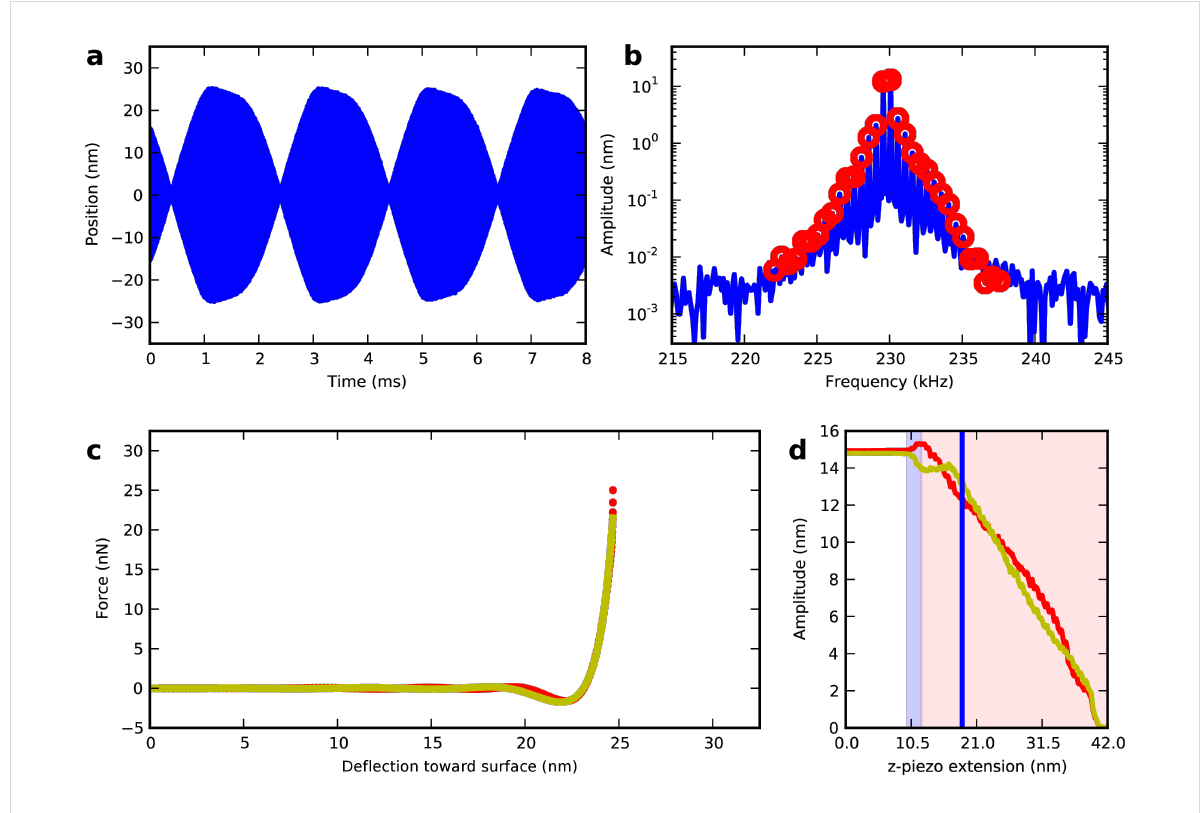
Figure 3: One frame from a surface approach movie (see Supporting Information File 1) showing strongly repulsive forces. The beating waveform (a) has the intermodulation spectrum around resonance (b) where red circles are analyzed to reconstruct the tip–surface force (c) using both polynomial (yellow) and ADFS (red) methods. The z-piezo extension z piezo = 18.7 nm is indicated by the blue vertical line in (d), which displays the amplitudes at the two drive frequencies. The interaction is purely attractive in the blue shaded area, becoming repulsive in the red shaded area.